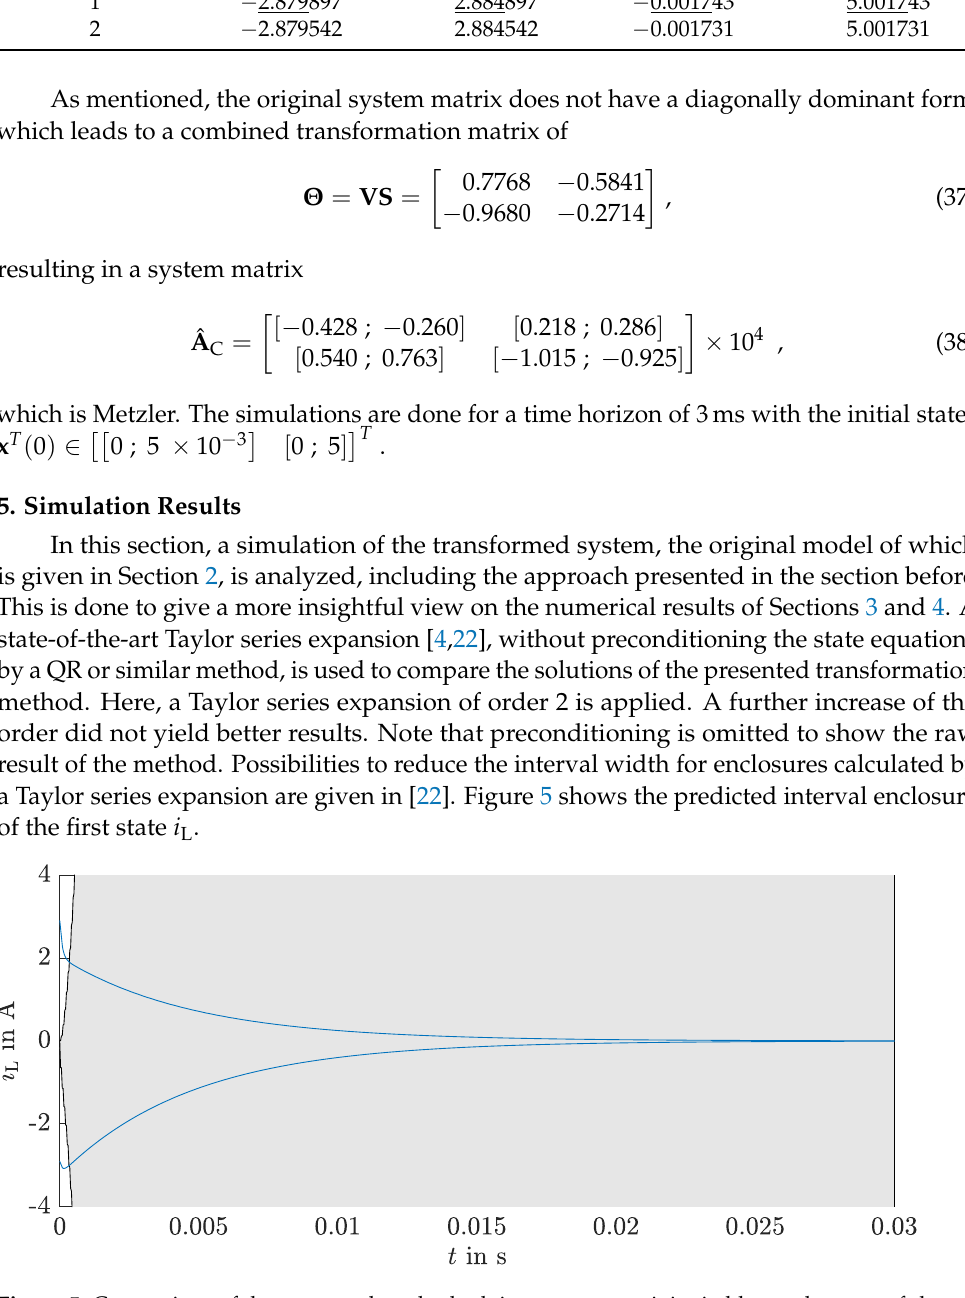
Figure 5. Comparison of the presented method relying on cooperativity in blue and a state-of-the-art Taylor series prediction in gray for the state variable i L